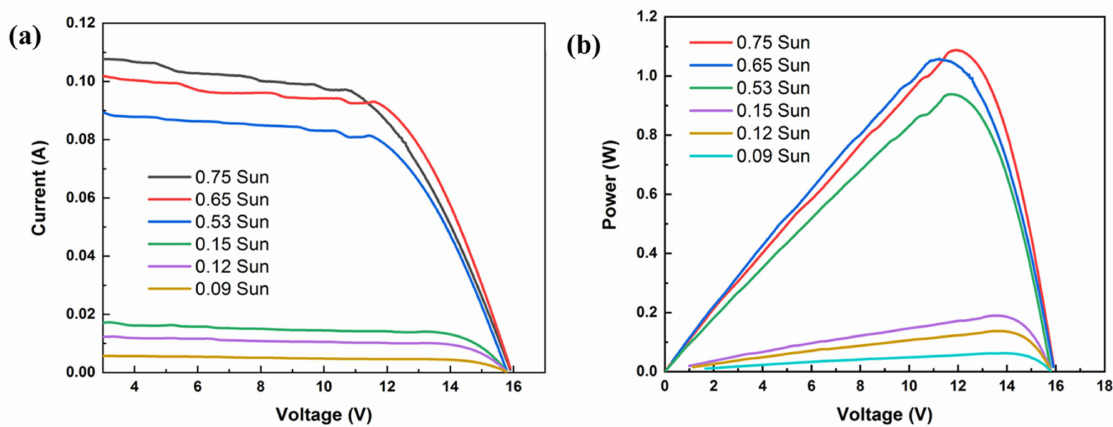
Figure 5. Experimental characteristic ( a ) I–V curves of the DSSCs panel in the sunlight.and ( b ) I–V curves of the DSSCs panel in the